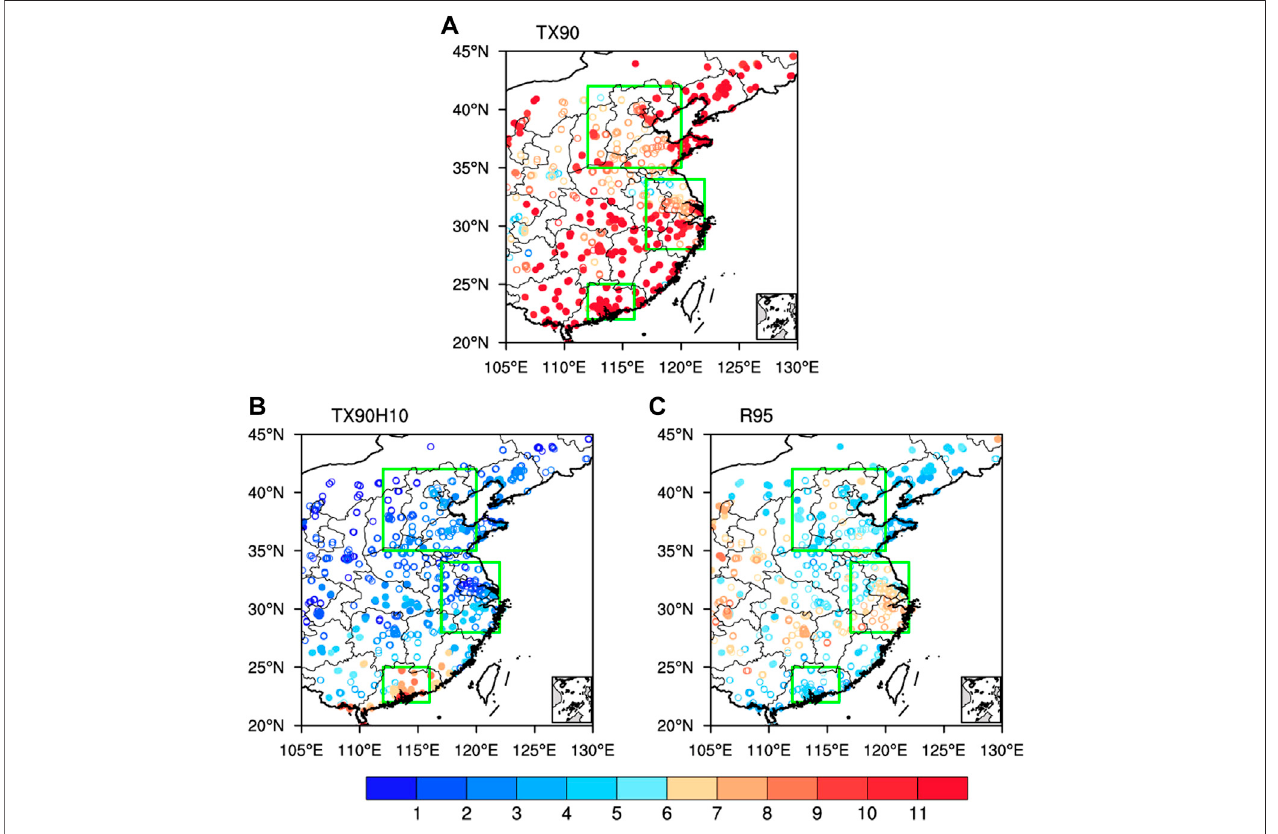
FIGURE1 | Observednumbers of (A) warm temperature events (TX90), (B) compoundhot and dry air events (TX90H10), and (C) heavy precipitation events (R95) in the summers of 2015 – 2021. The solid circles indicate that the mean extreme weather days during 2015 – 2021 were higher than that during 1981 – 2014. The green boxes represent the location of North China, Yangtze River Delta, and Pearl River